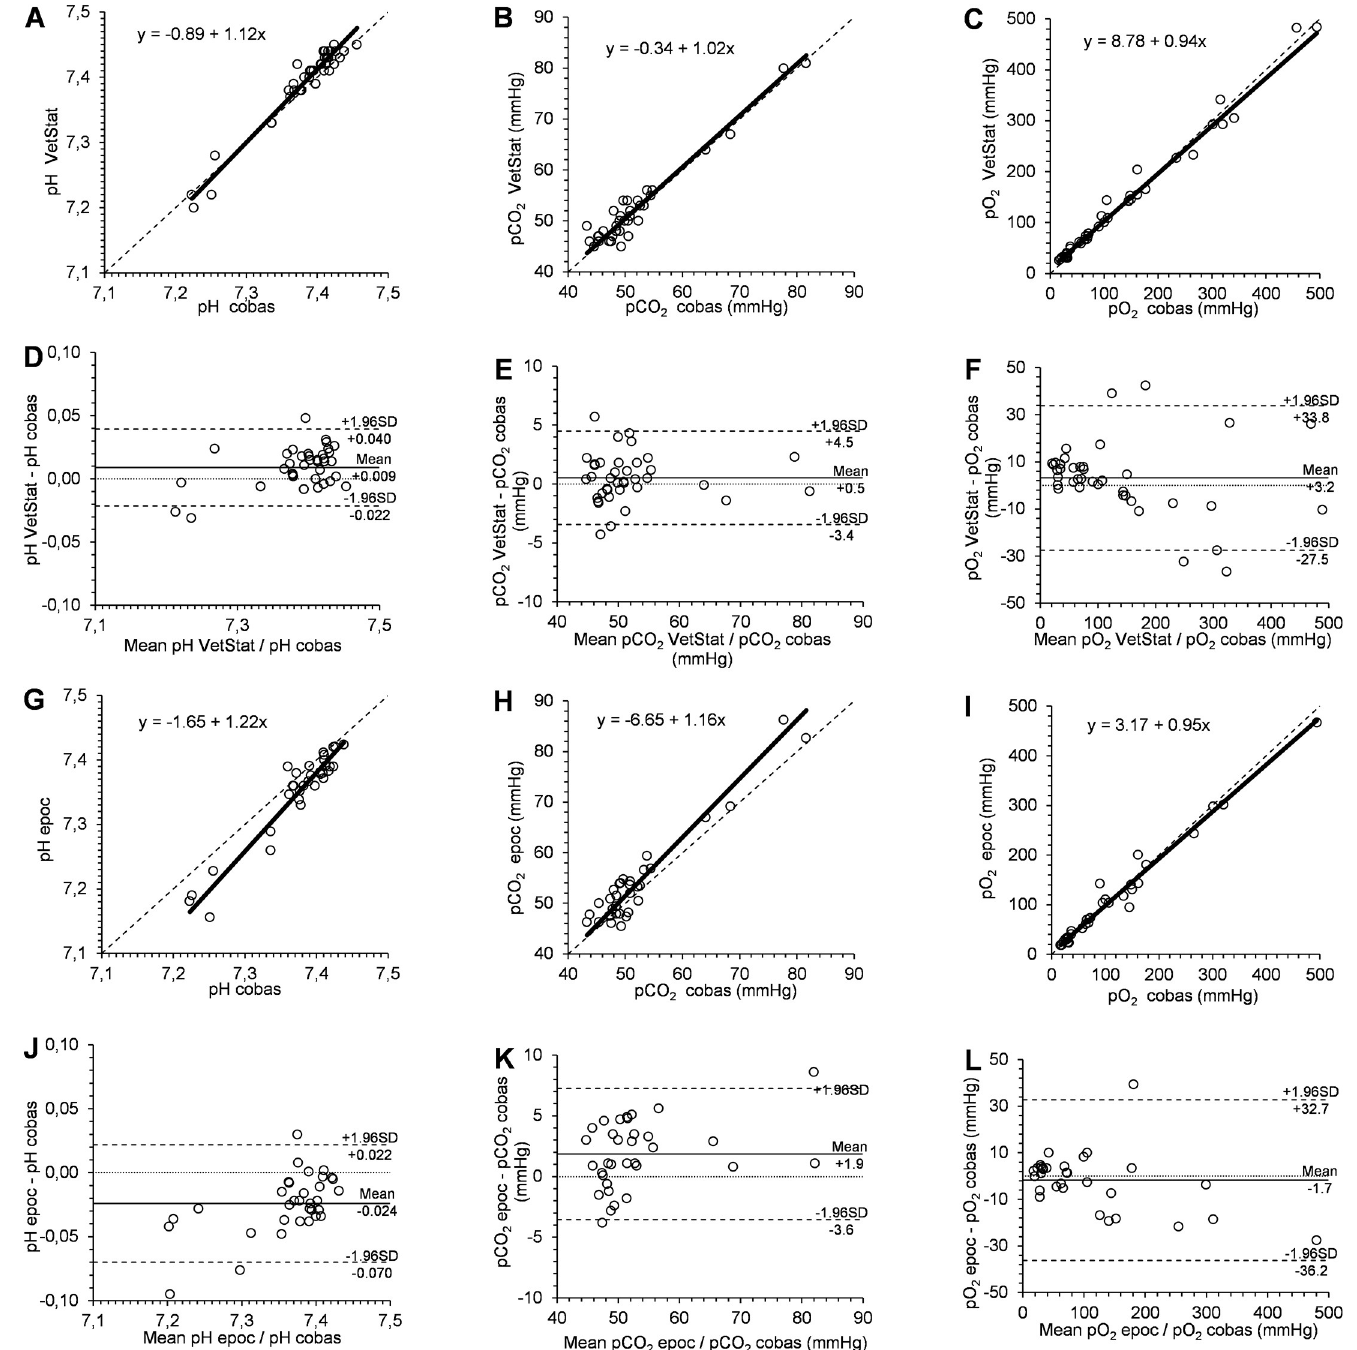
Fig 1. Passing-Bablok regression analysis and Bland-Altman plot analysis for comparison of different analyzers for blood pH, pCO 2 , and pO 2 .